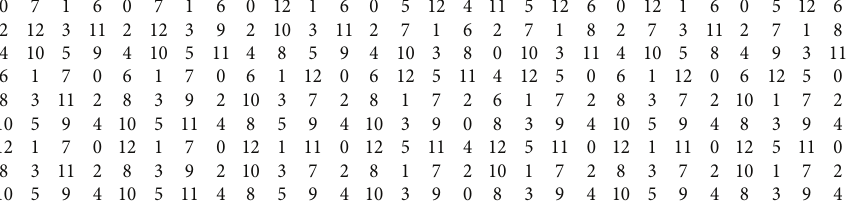
Figure 5: 12 - 𝐿(2,1) -labeling of 𝐶 9 ⊠ 𝐶 28